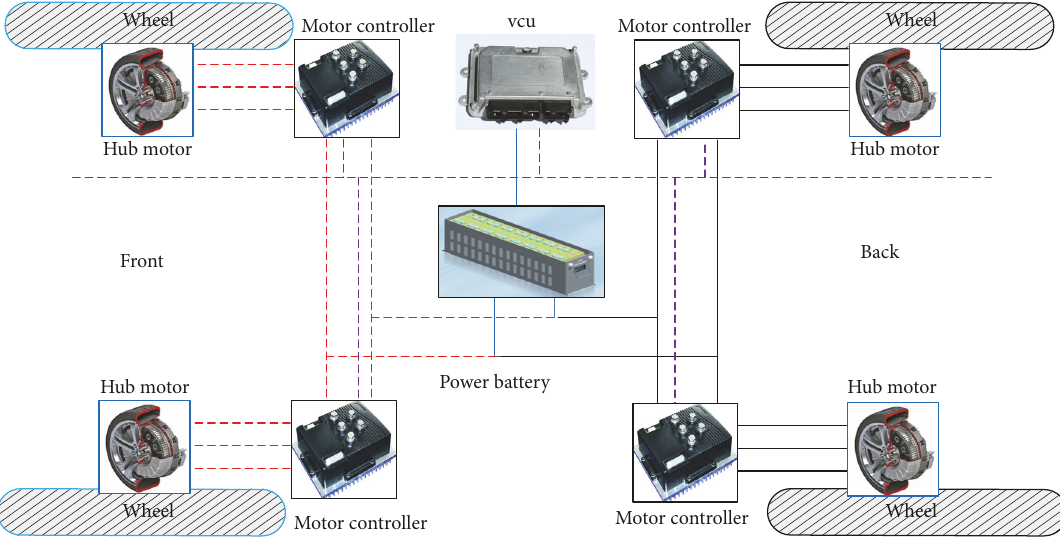
Figure 2: Two-wheel drive